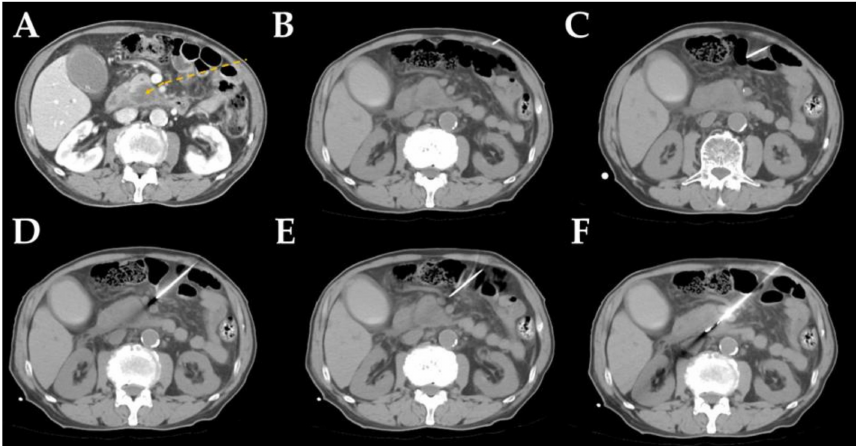
Figure A2. CT-guided core needle biopsy images via detour route 2.